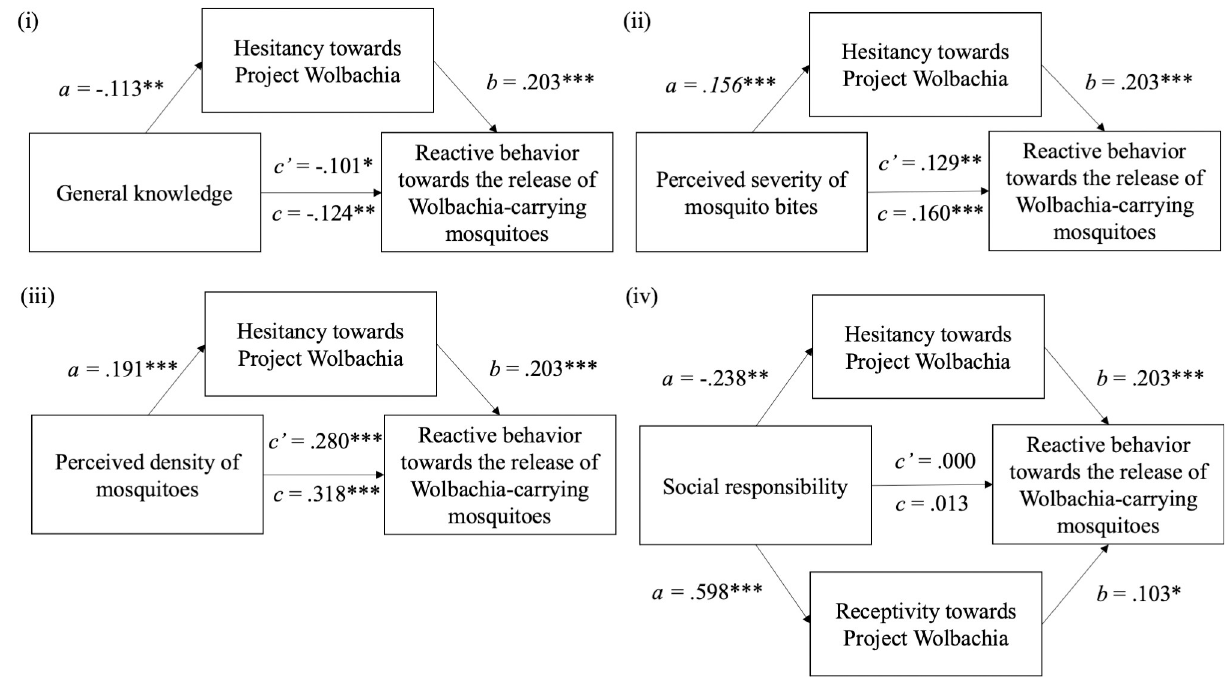
Fig 3. Roles of hesitancy towards Project Wolbachia –Singapore and receptivity towards Project Wolbachia –Singapore as mediators. Each numerical value is the standardized regression coefficient for that pathway. a refers to the direct effect of predictor on the mediator, b refers to the direct effect of the mediator on the outcome, c’ refers to the direct effect of the predictor on the outcome, while c refers to the total effect (direct + indirect effect of the predictor on the outcome).